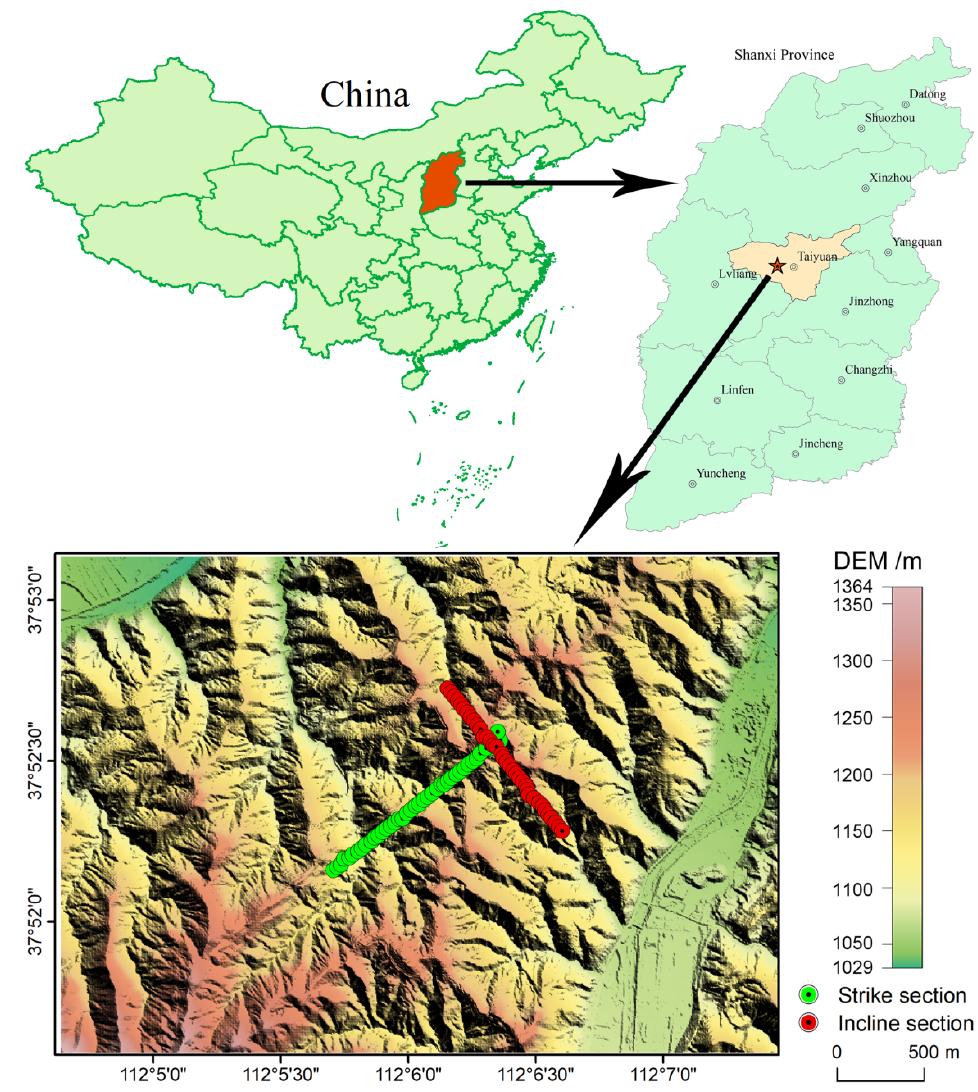
Figure 1. Study area and the distribution of the workface.